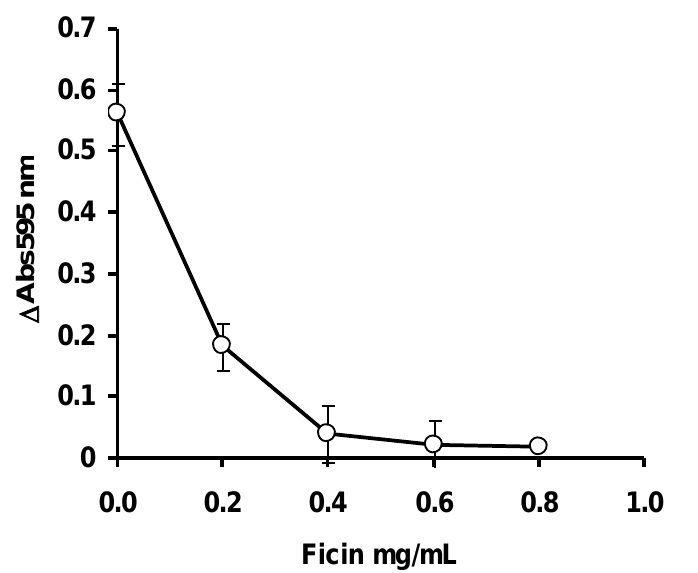
Figure 2. The effect of ficin concentration on the ficin dye-binding assay. Error bars represent mean ± standard deviation ( n = 3).